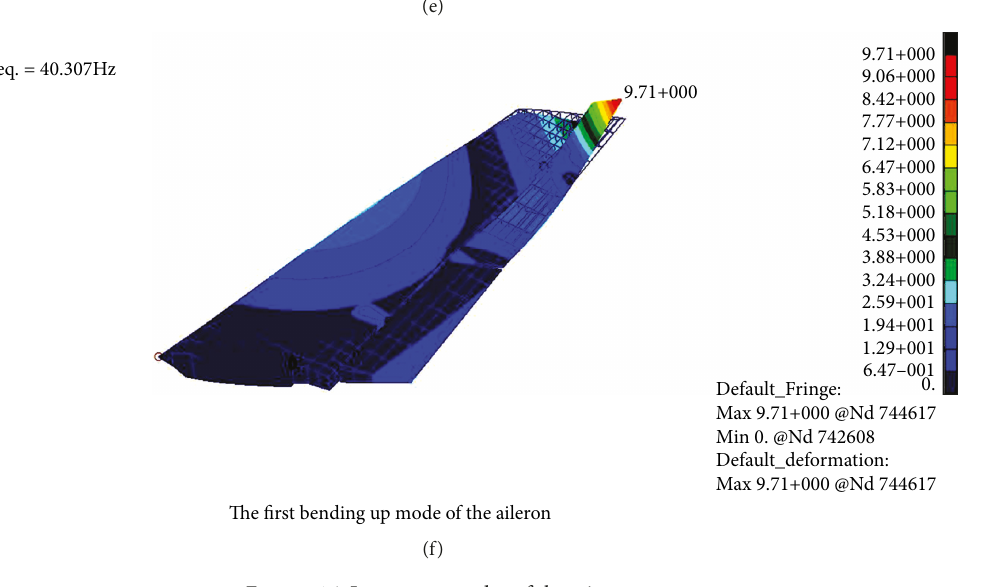
Figure 16: Important modes of the